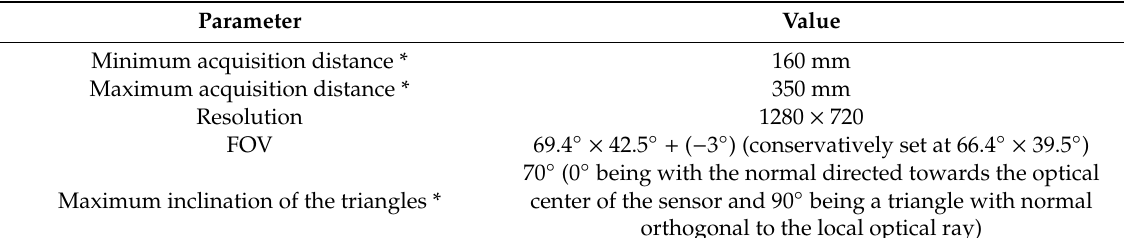
Table 3. Parameters used to model the behavior of the D415 camera in the study.